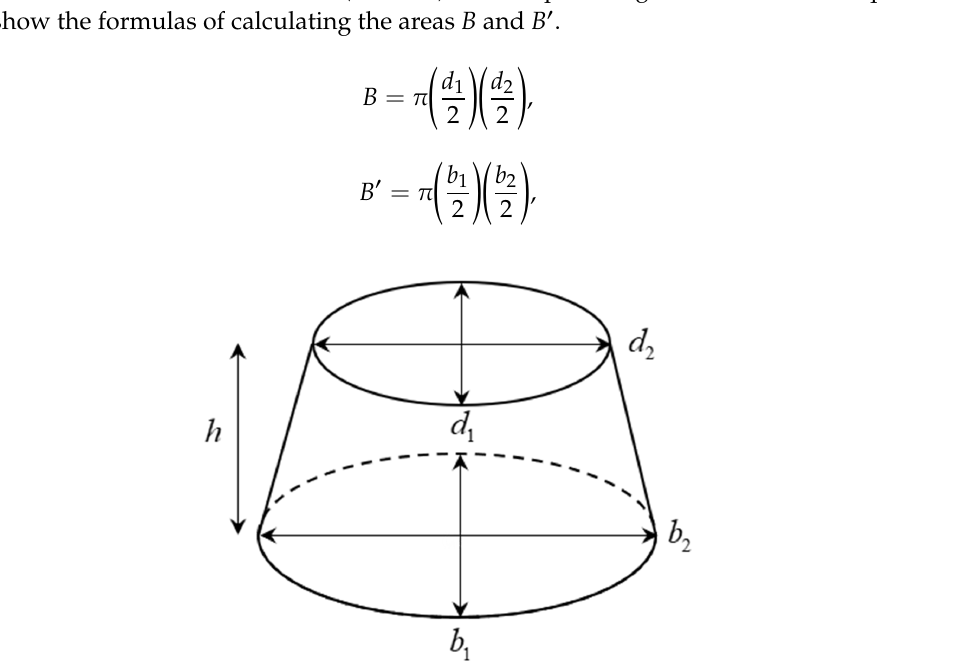
Figure 5. Cross-section of an elliptical vegetable or fruit.